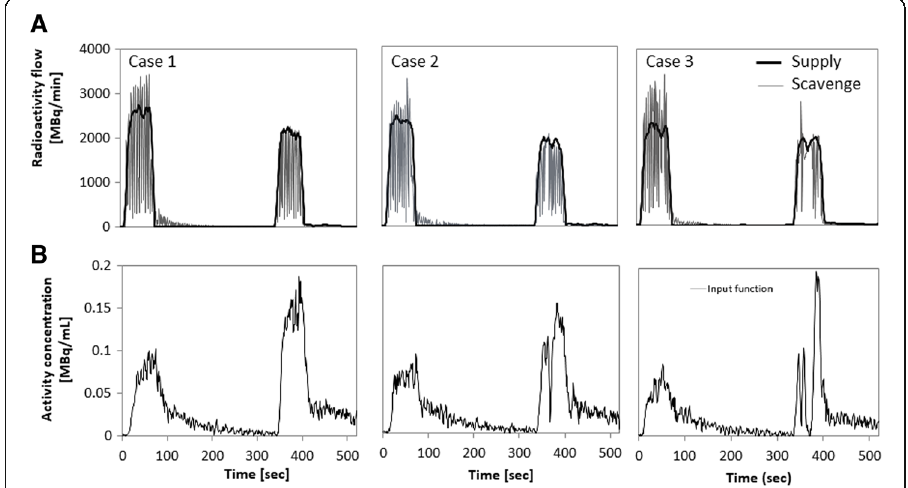
Fig. 6 Comparison of the gaseous radioactivity curves in the supply and scavenging tubes (upper) with AIF (lower) assessed with arterial blood sampling in typical three example